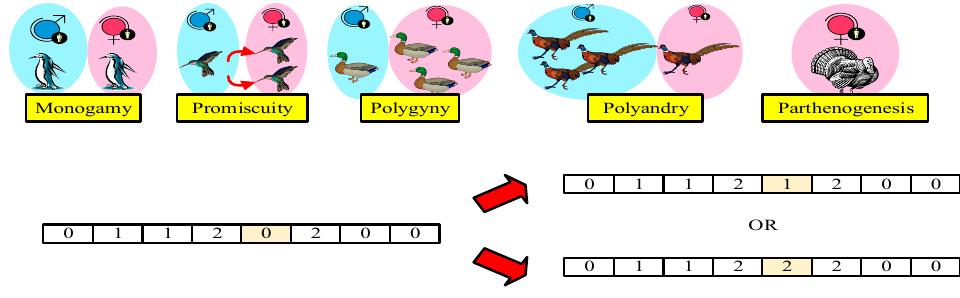
Figure 2. Mutation process of all species of birds.